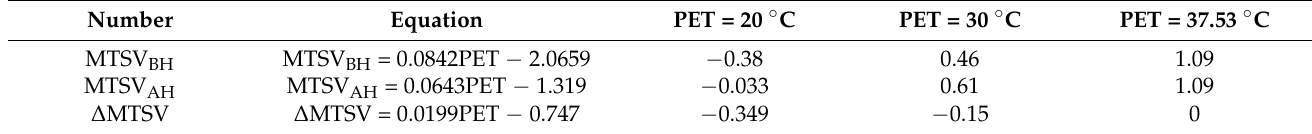
Table 7. PET and MTSV equation analyses (BH: before horticulture; AH: after horticulture).